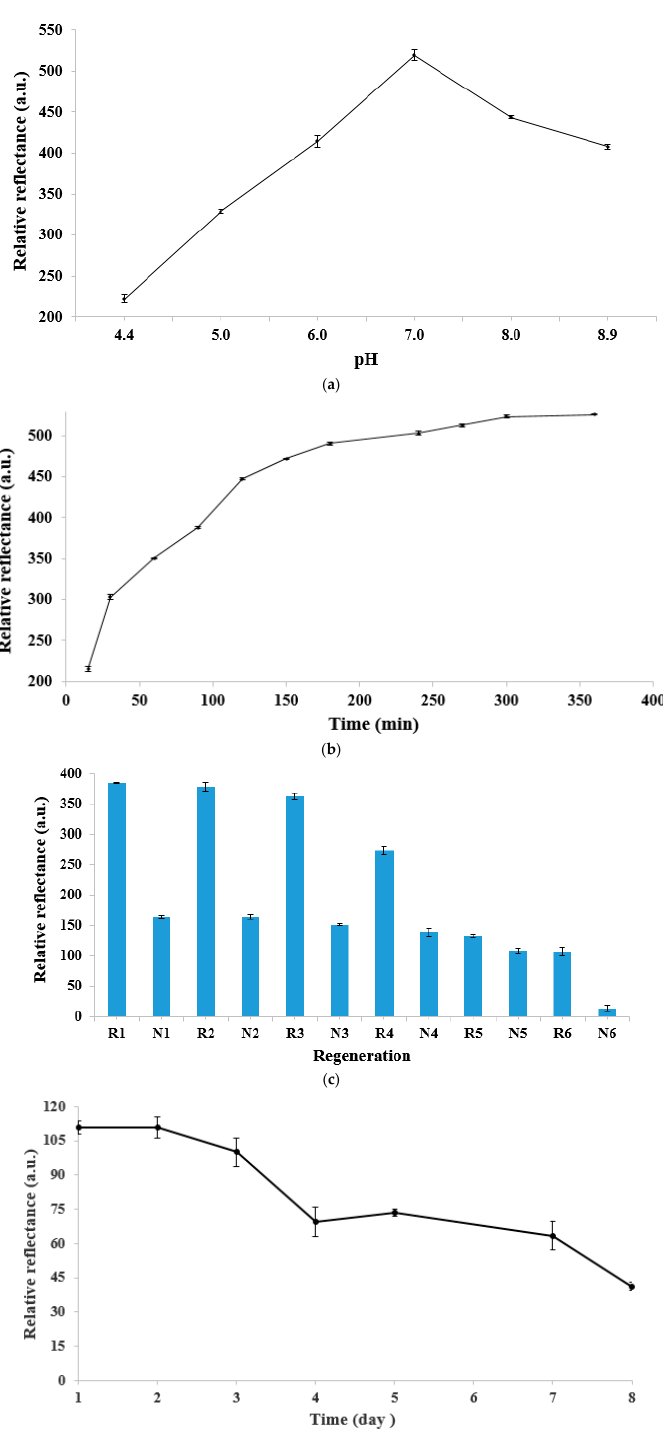
Figure 3. ( a ) The sandwich-type DNA micro-optode response toward the detection of 1 pM cDNA in 0.05 M K-phosphate buffer from pH 4.4 to pH 8.9 at 637 nm ( n = 3). ( b ) The response time curve of the optical DNA biosensor upon sandwich DNA detection of 1 pM cDNA at 637 nm ( n = 3). ( c ) Reversibility of the DNA biosensor after sandwich DNA hybridization treatment with 1 pM cDNA at pH 7.0 for 90 min (R) and regeneration with 0.1 M NaOH solution for 10 min (N) in ambient conditions ( n = 3). ( d ) The long-term stability profile of the optical DNA biosensor for sensing of 1 pM dengue virus DNA for an experimental time period of seven days ( n = 3).